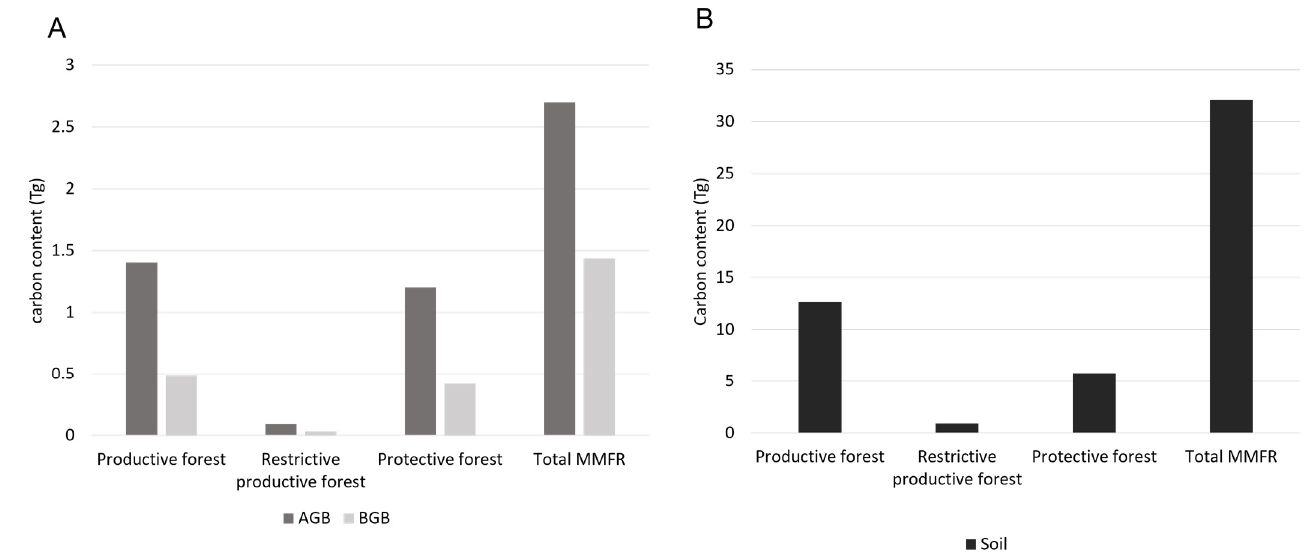
Figure 2. Carbon content (Tg) in the different zones of the MMFR and in the total area for AGB and BGB ( A ) and soil ( B ).